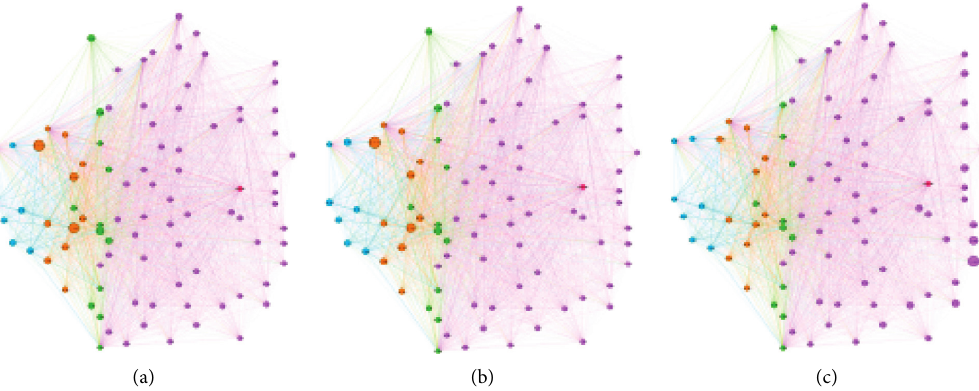
Figure 14: N network based on IR . 91 paintings by Mark Rothko colored by artistic style (see Table 3). (a) Creativity scores in terms of size 3 5 of nodes. (b) Combination of originality and influence by parameter β � 0 . 1. In this case, influence is given 90% of the weight in the calculation of the score. (c) Just as previous image, β � 0 . 9, originality is given 90% of the